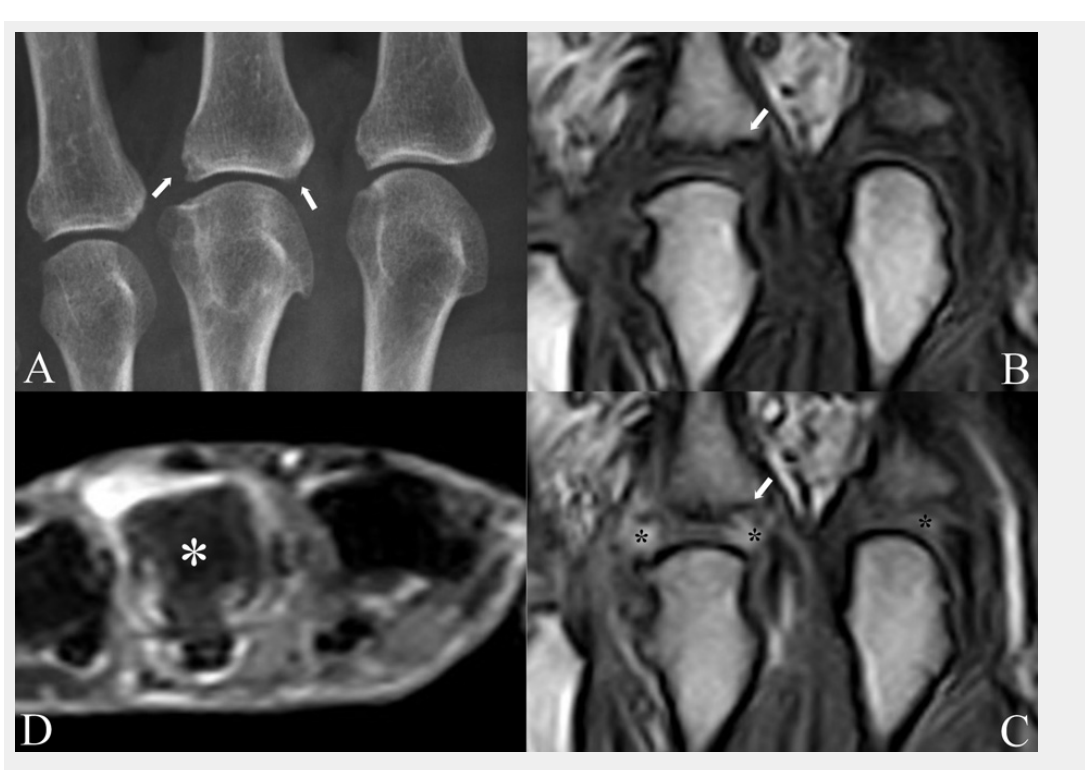
Figure 1 Conventional radiography and MRI study of the metacarpophalangeal joints of a patient with undifferentiated oligoarthritis lasting from less than 6 months. A) the radiogram shows degenerative changes (osteophytes) of the 3 rd metacarpophalangeal head and small erosions (arrows) of the proximal end of the corresponding phalanx. The erosion on the right is only suspected because of an interrupted bony cortex; pre (B) and post- contrast (C) coronal Turbo 3D MRI sequences showing synovial enhancement of the painful 3 rd metacarpophalangeal joint (asterisks) and confirmation of the suspected erosion (arrow). Inflammation is present also in the asymptomatic and clinically normal 2 nd metacarpophalangeal joint (asterisk). Axial STIR MRI sequence (D) showing intense bone marrow oedema of the 3 rd metacarpal head (asterisk), which appears gray in comparison with the normal bone of the other metacarpals, which appears black. All MRI images are obtained with an extremity-dedicated 0.2 T machine (Esaote, Genova, Italy).